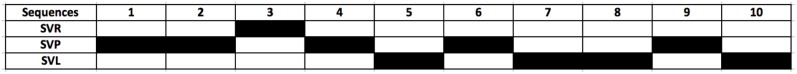
Succession of the vitality states in sequences identified from the runners’ courses of experience.